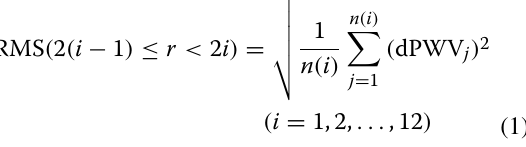
due to the variable geometry of satellite–receiver line of sights during heavy rainfall could be reduced by about 20% if PWV SPD-H is retrieved by using the QZSS satellite at the highest elevation instead of using the GPS satellite at the highest elevation (Oigawa et al. 2014). During the Uji heavy rainfall event, the QZSS satellite did not exist close to the zenith. Therefore, the GPS satellites above 60° elevation angle were used to estimate PWV SPD-H . Figure 3a indicates the time variation of the 10-min rainfall observed by a rain gauge at RISH. To investigate the degree of the spatial inhomogeneity of PWV around